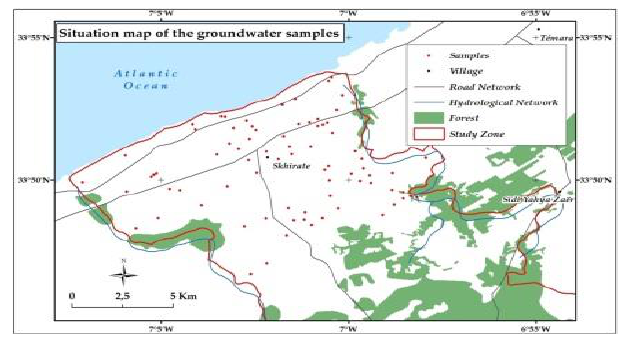
Figure 1. Location of water samples.